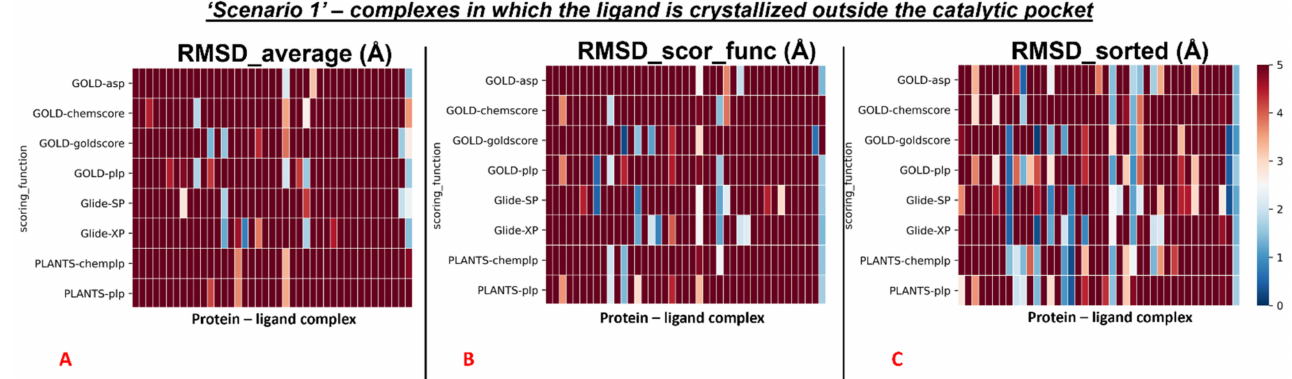
Figure 5. Colormaps represent the results of the self-docking experiments just for the ligands crystallized outside the orthosteric pocket in the case in which the crystallographic water molecules are not considered during the docking runs. ( A ) Results coming from the average of the RMSDs of all the poses for each docking run. ( B ) Results derived just from the RMSD between the crystallographic ligand coordinates and the pose classified as the best from the scoring function. ( C ) Results of the self-docking experiments if just the pose showing the best RMSD value between its coordinates and the crystallographic ones is retained. The x -axis lists all the different protein–ligand complexes, which are plotted against the different pairs docking program-scoring function used for this study, reported in the y